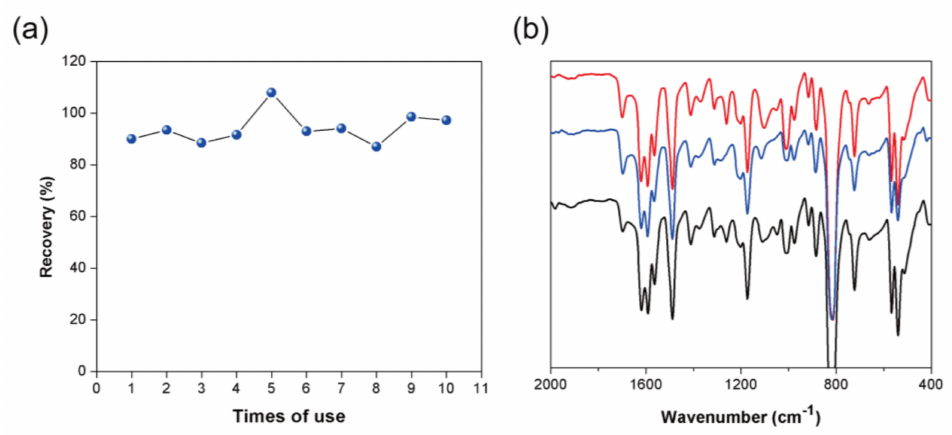
Figure 5. ( a ) Effect of time of use on recovery; ( b ) FTIR spectra comparison without the SPE process (blue), 10 cycles (black), and after 100 cycles (red).